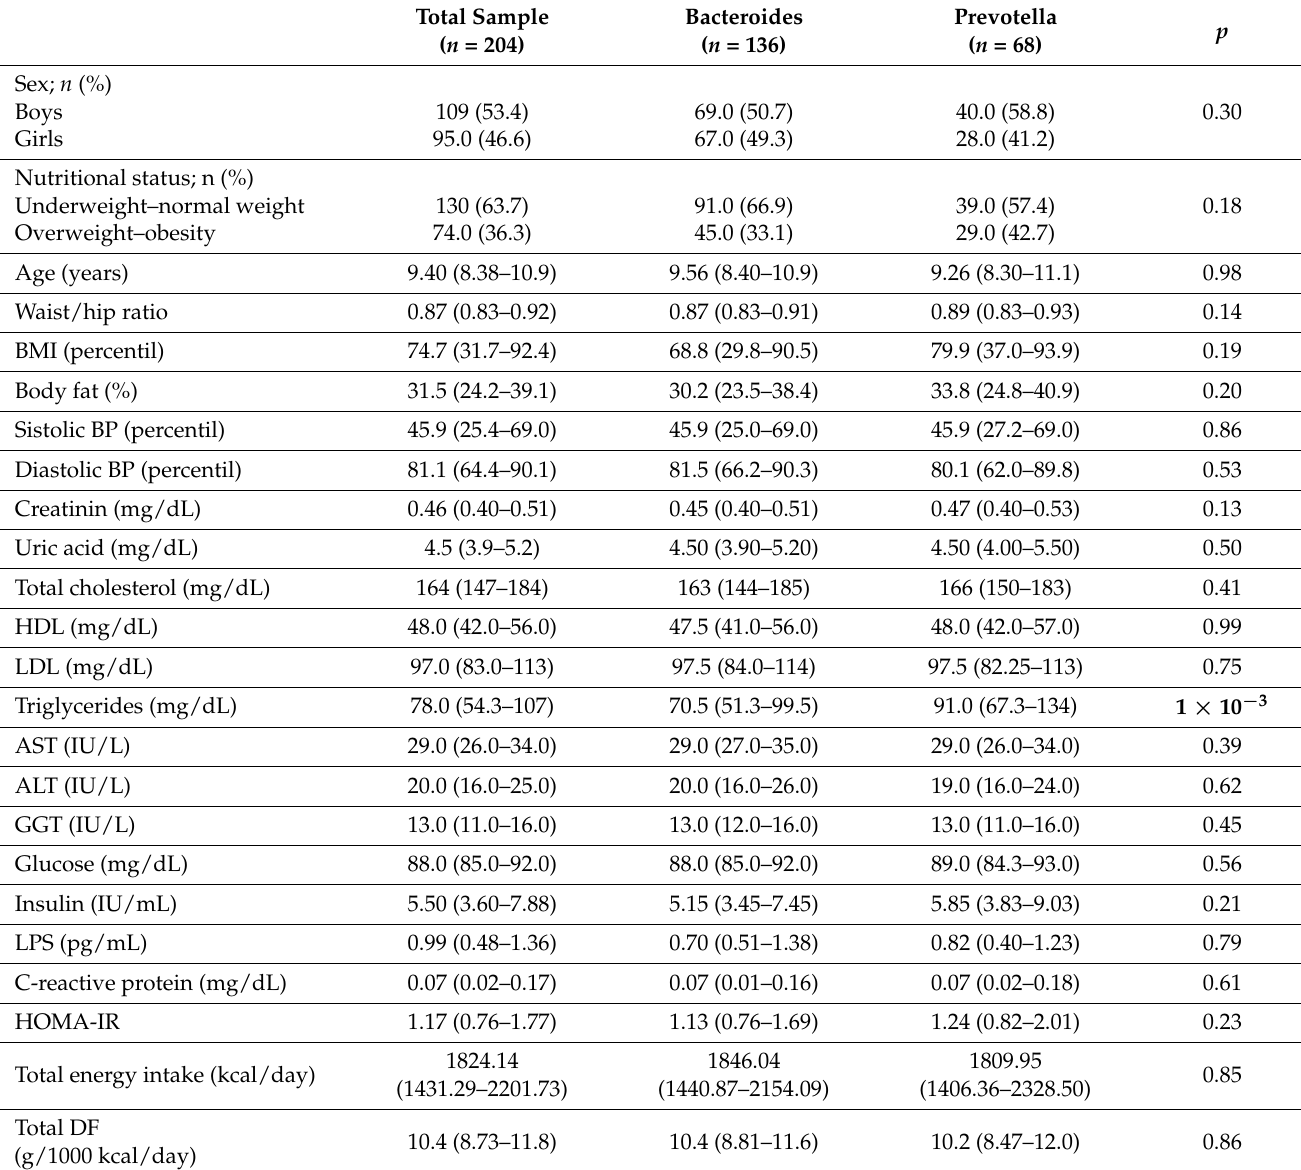
Table 1. Characteristics of the children included in the